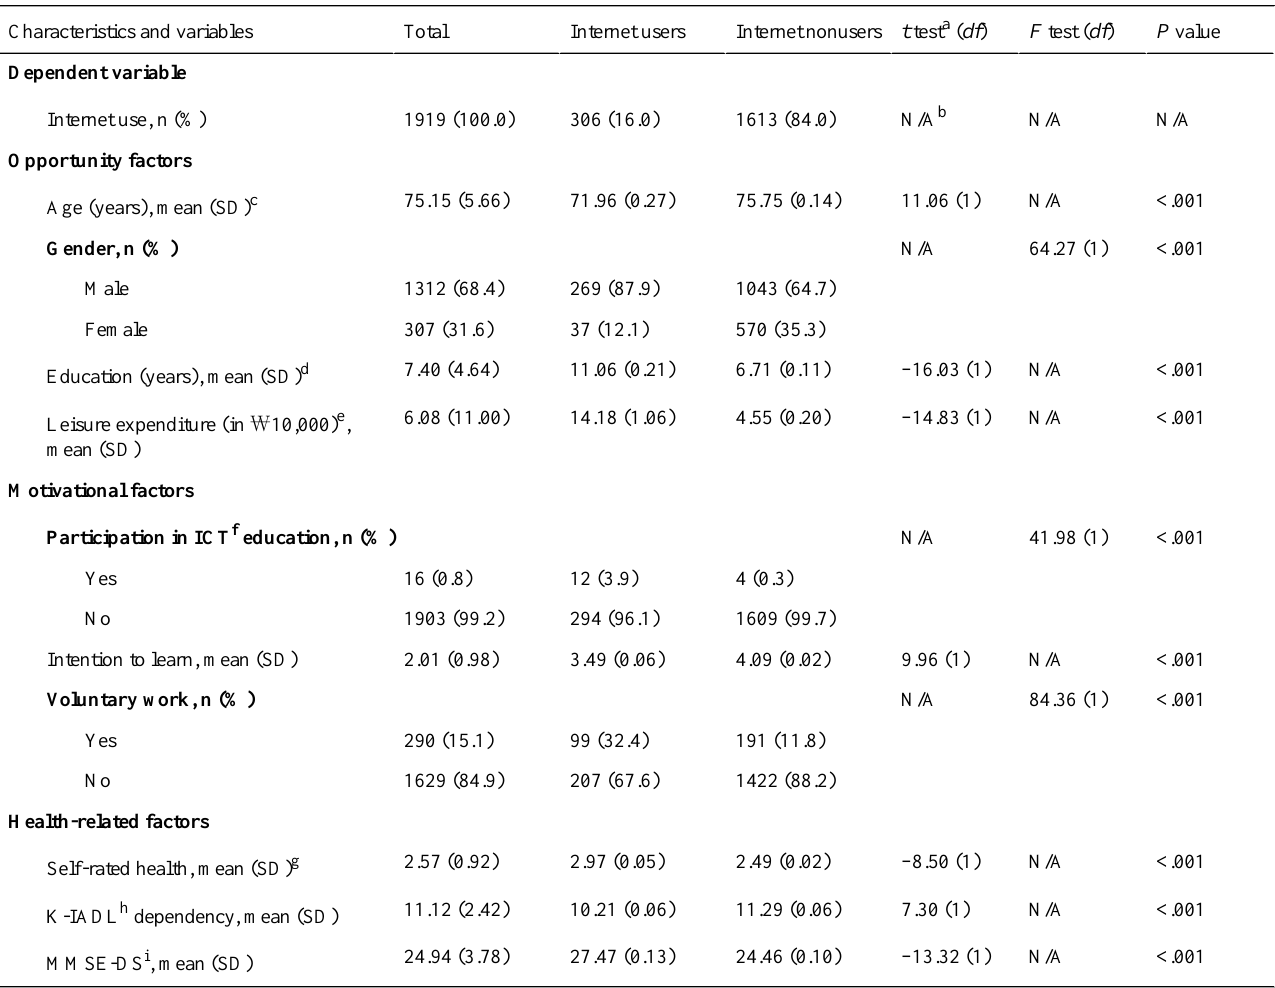
Table 1. Participant characteristics